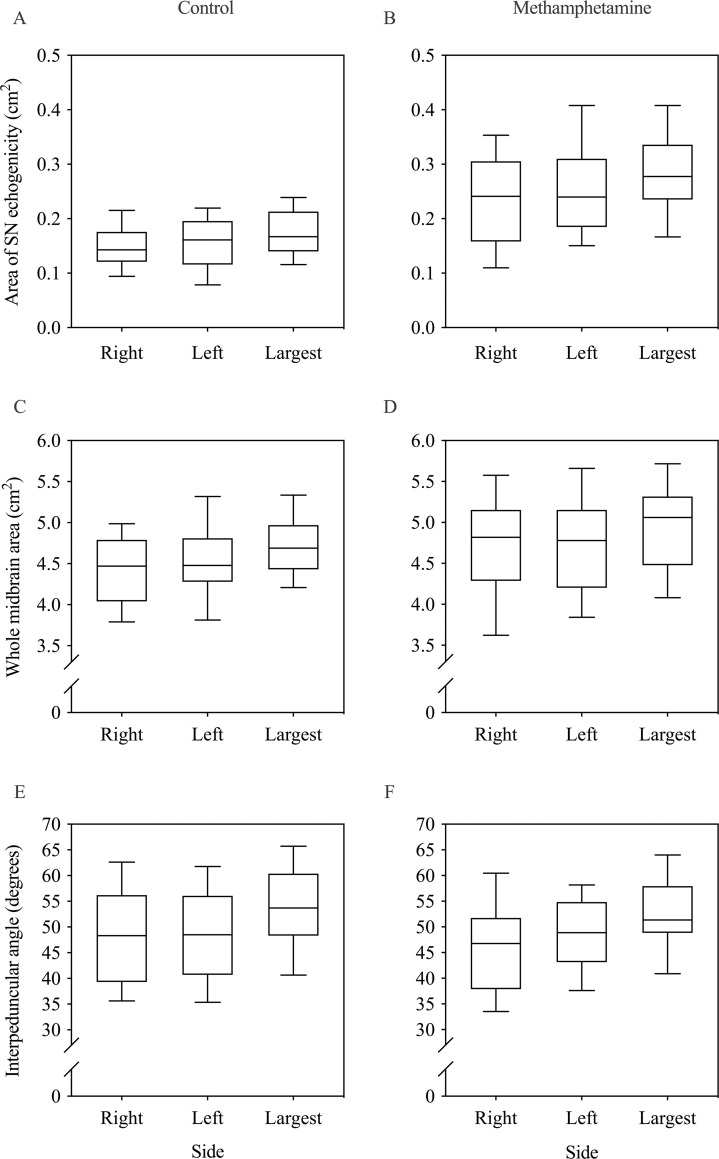
Group data showing the midbrain and substantia nigra measurements on the right and left side and largest side.The boundary of each box represents the 25th and 75th percentile and the whiskers (error bars) represent the 10th and 90th percentiles. The solid line within each box is the median. A and B) Area of substantia nigra (SN) echogenicity in the control group (A) and methamphetamine group (B). C and D) Cross-sectional area of the whole midbrain in the control group (C) and methamphetamine group (D). E and F) Interpeduncular angle in the control group (E) and methamphetamine group (F).